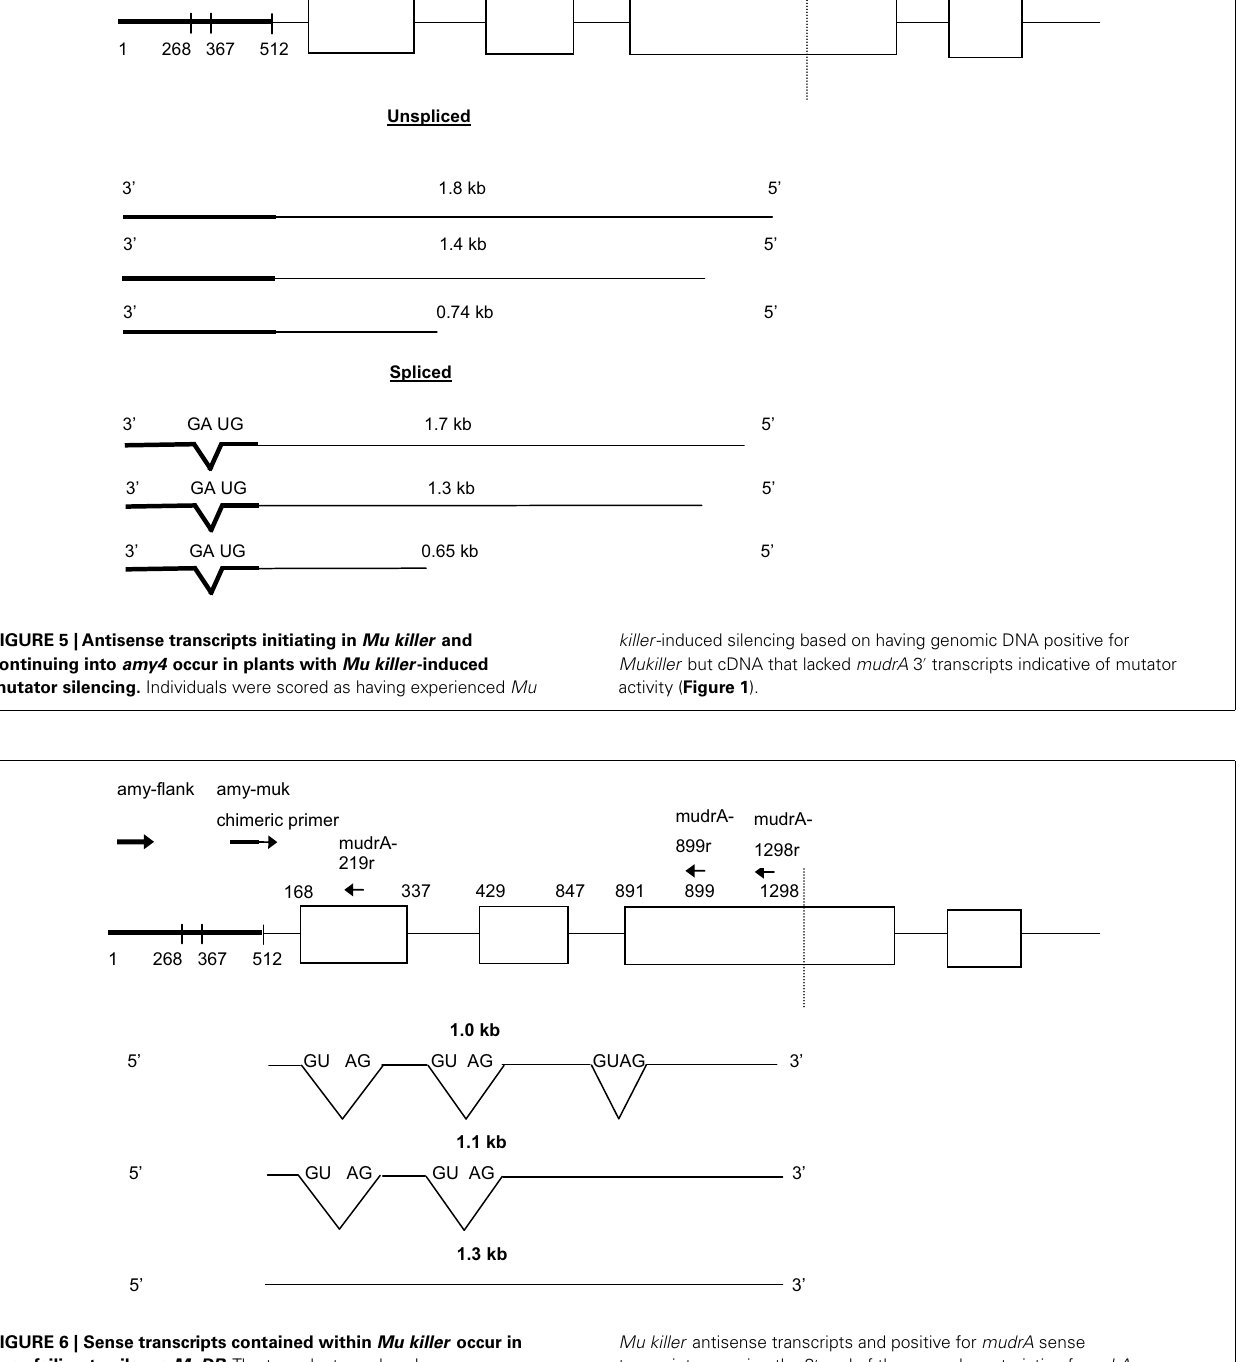
FIGURE 6 | Sense transcripts contained within Mu killer occur in lines failing to silence MuDR . The two plants analyzed were genotyped as Mu killer carriers, however, the cDNA is negative for